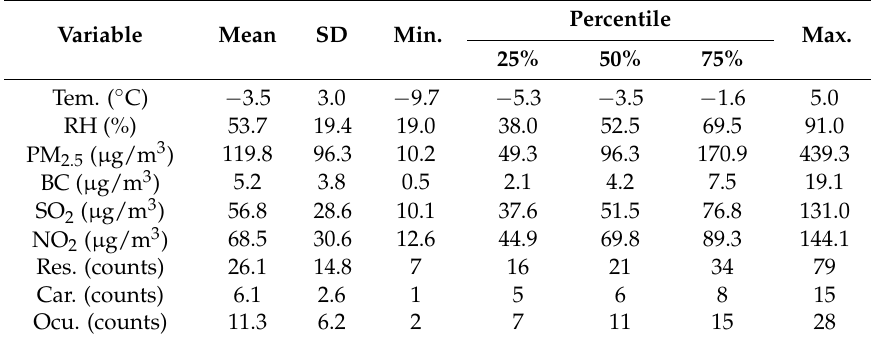
Table 1. Descriptive statistics of daily environmental variables and hospital emergency admissions over a three month period. RH: relative humidity.